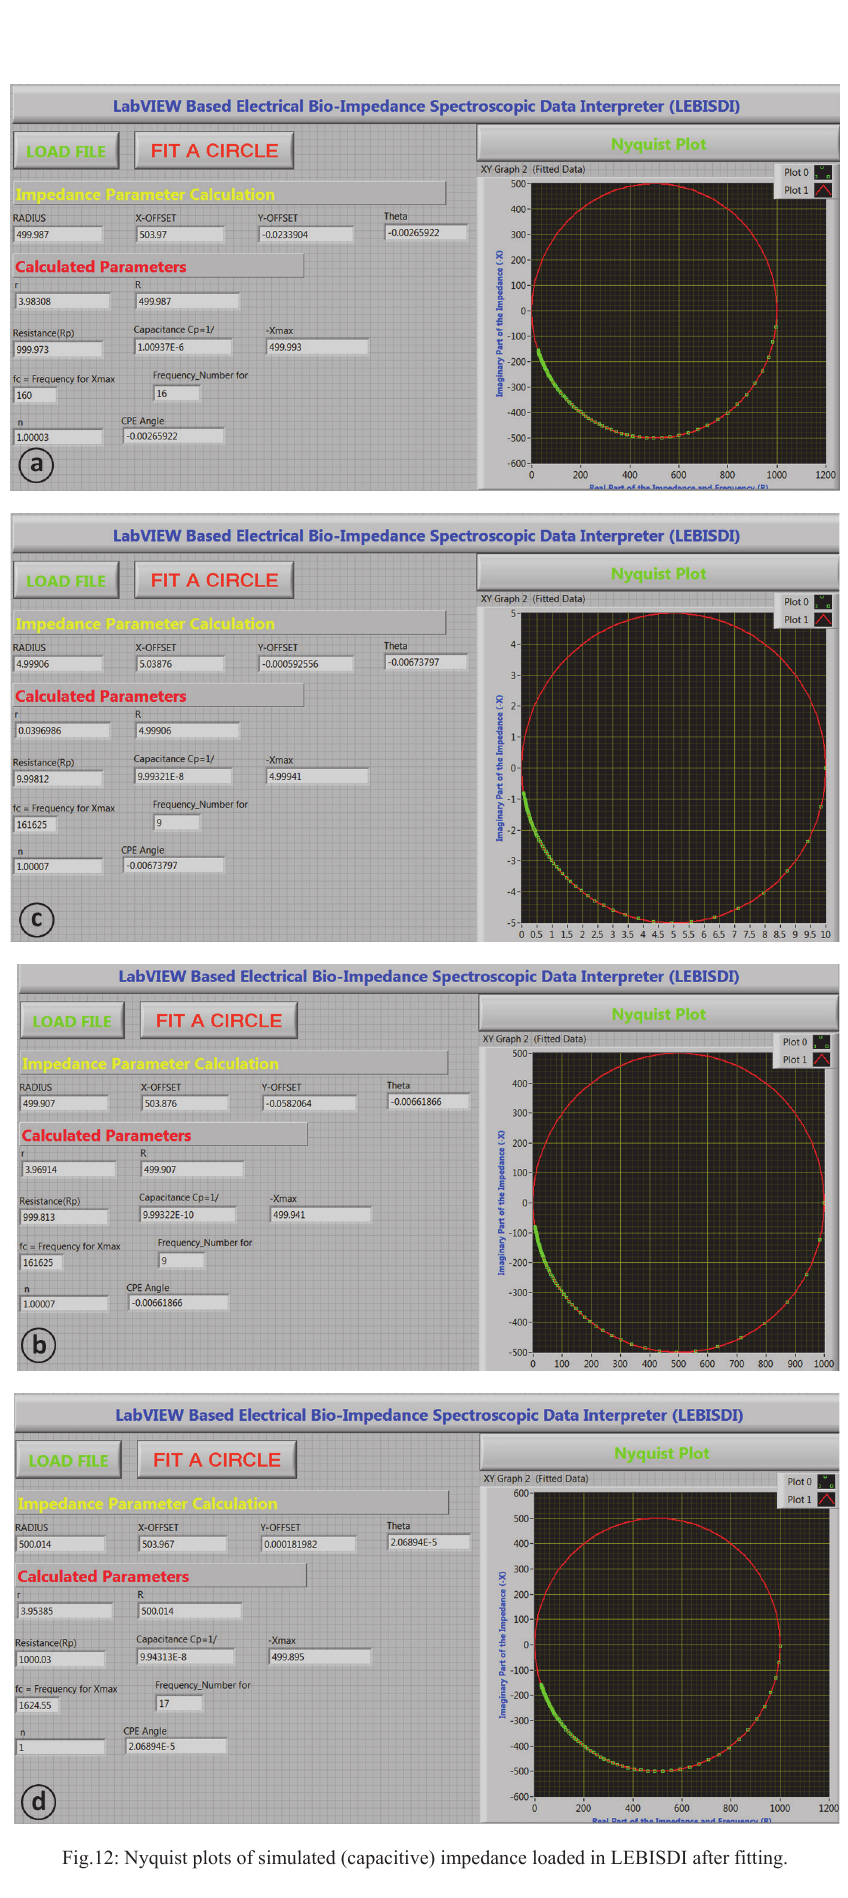
Fig.12: Nyquist plots of simulated (capacitive) impedance loaded in LEBISDI after